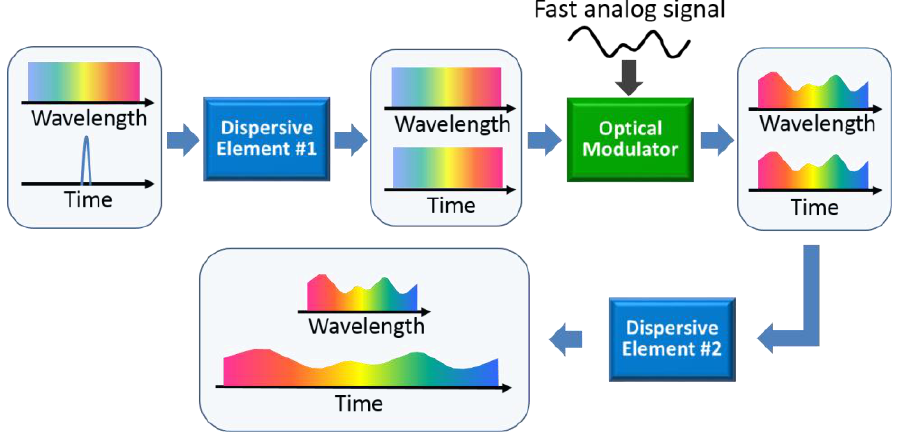
Figure 12. Schematic diagram of DFT-enabled photonic time stretch analog-to-digital conversion